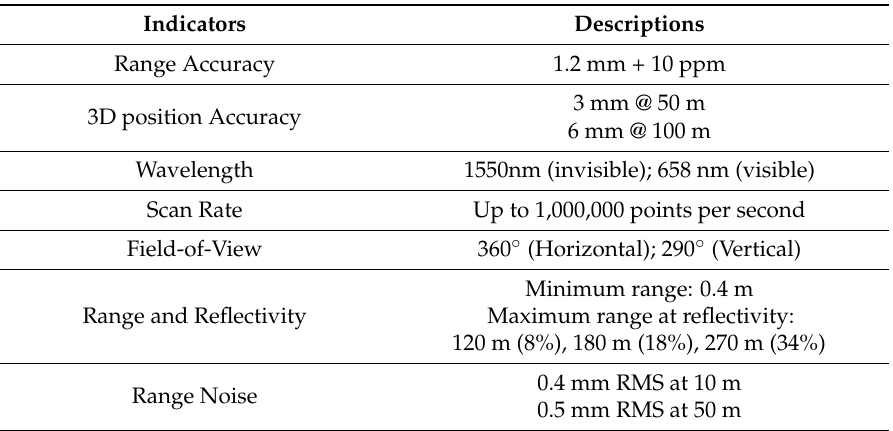
Table 1. Main performance indicators of Leica P40.